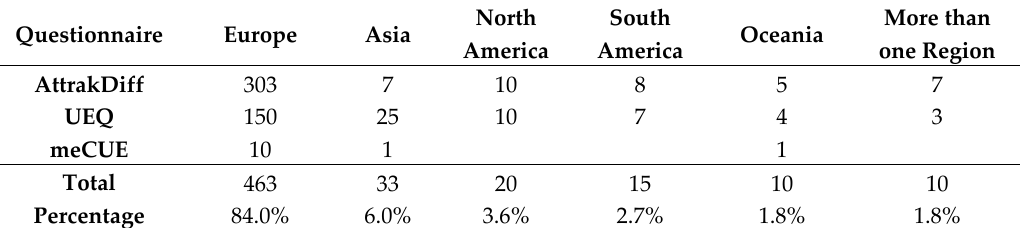
Table 3. Total number of uses of standardized questionnaires by geographical